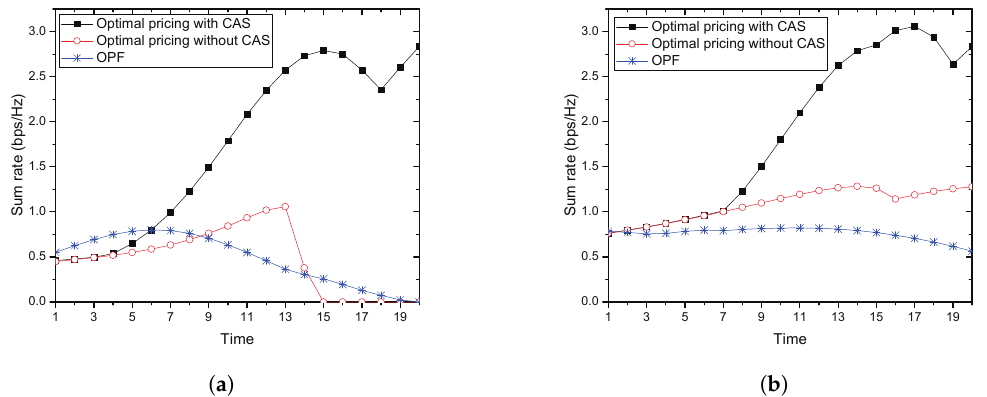
Figure 11. Comparison of sum-rates with multiple jammers. ( a ) When the number of jammers is four; ( b ) when the number of jammers is